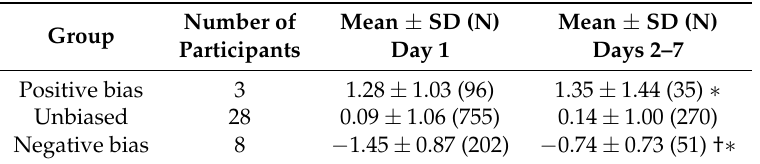
Table 3. Group summaries from bias persistence analysis. Mean: Mean of the errors [mmol/L]. SD: Standard deviation of the errors [mmol/L]. N: number of paired points. †: Group mean in days 2–7 is significantly different from the group mean in day 1. ∗ : Group mean is significantly different from the unbiased group mean (days